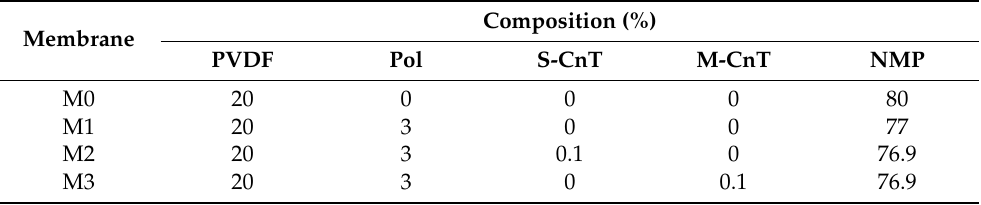
Table 1. Composition of membrane